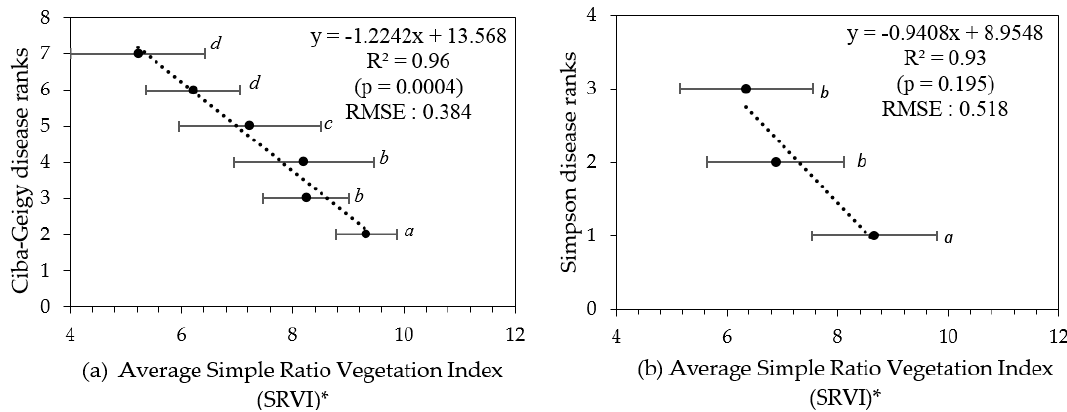
Figure 7. ( a ) Ciba-Geigy and ( b ) Simpson disease ranks versus average simple ratio vegetation index (SRVI) values (respective trees grouped into their disease ranks). * Error bars indicate the standard deviation for each category. Means with similar letters are not significantly different from each other at p > 0.05.